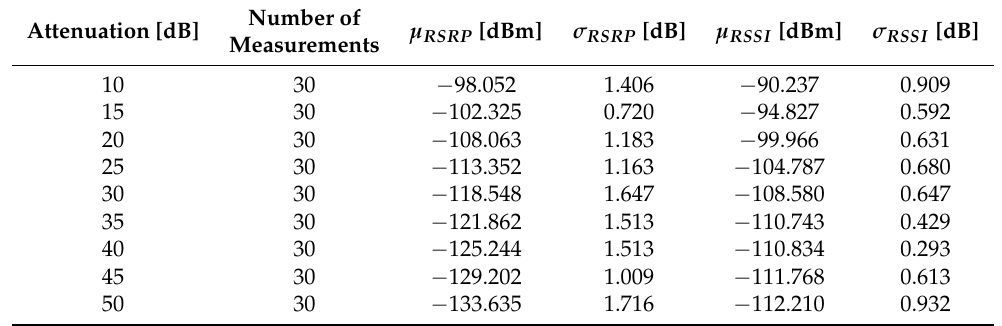
Figure 6. Analysis of different signal level measurements as an expression for coupling loss. ( a ) Distribution of RSRP signal levels for artificial attenuation in 5 dB steps. ( b ) Comparison between RSRP and RSSI for various levels of artificial attenuation. Table 3. Mean values ( µ RSRP , µ RSSI ) and standard deviation ( σ RSRP , σ RSSI ) of the RSRP and RSSI